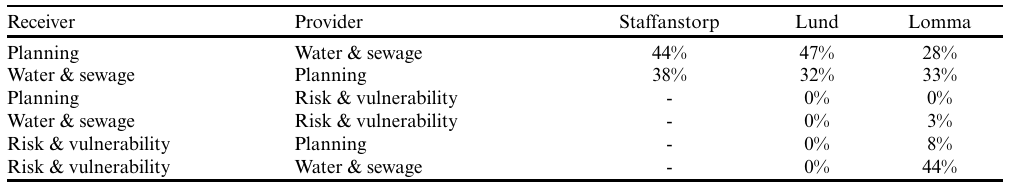
Table 3 . Proportion of total importance of input from other types of actors.